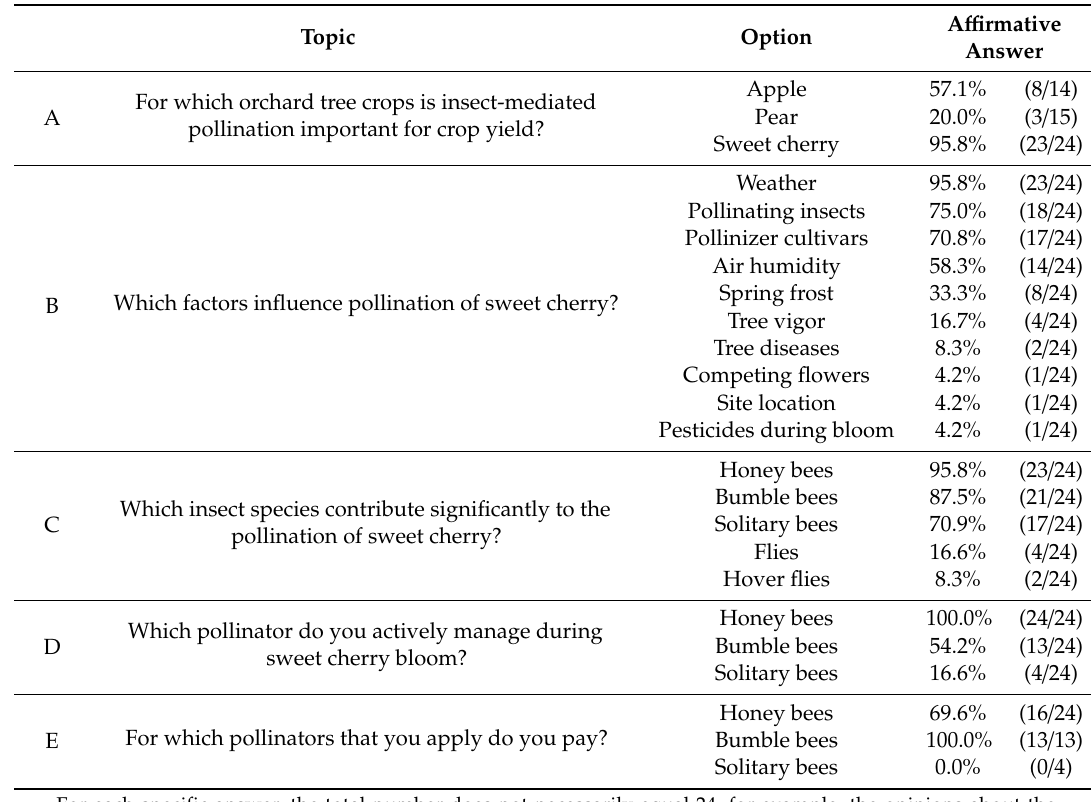
Table 1. Questions about knowledge of pollination, pollinators and current practices that were covered during the semi-structured interviews with sweet cherry growers. The number of growers that gave a certain answer per question is given (percentage and actual